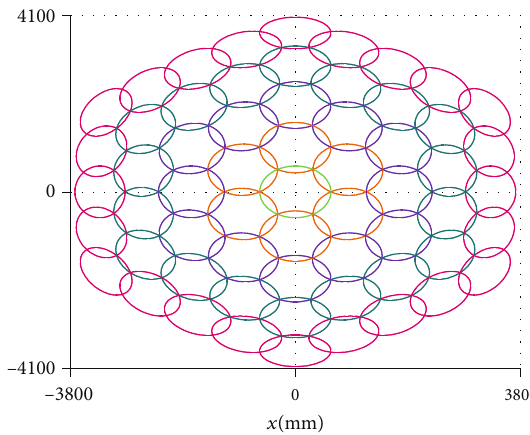
Figure 16: Top view of the envelope circle